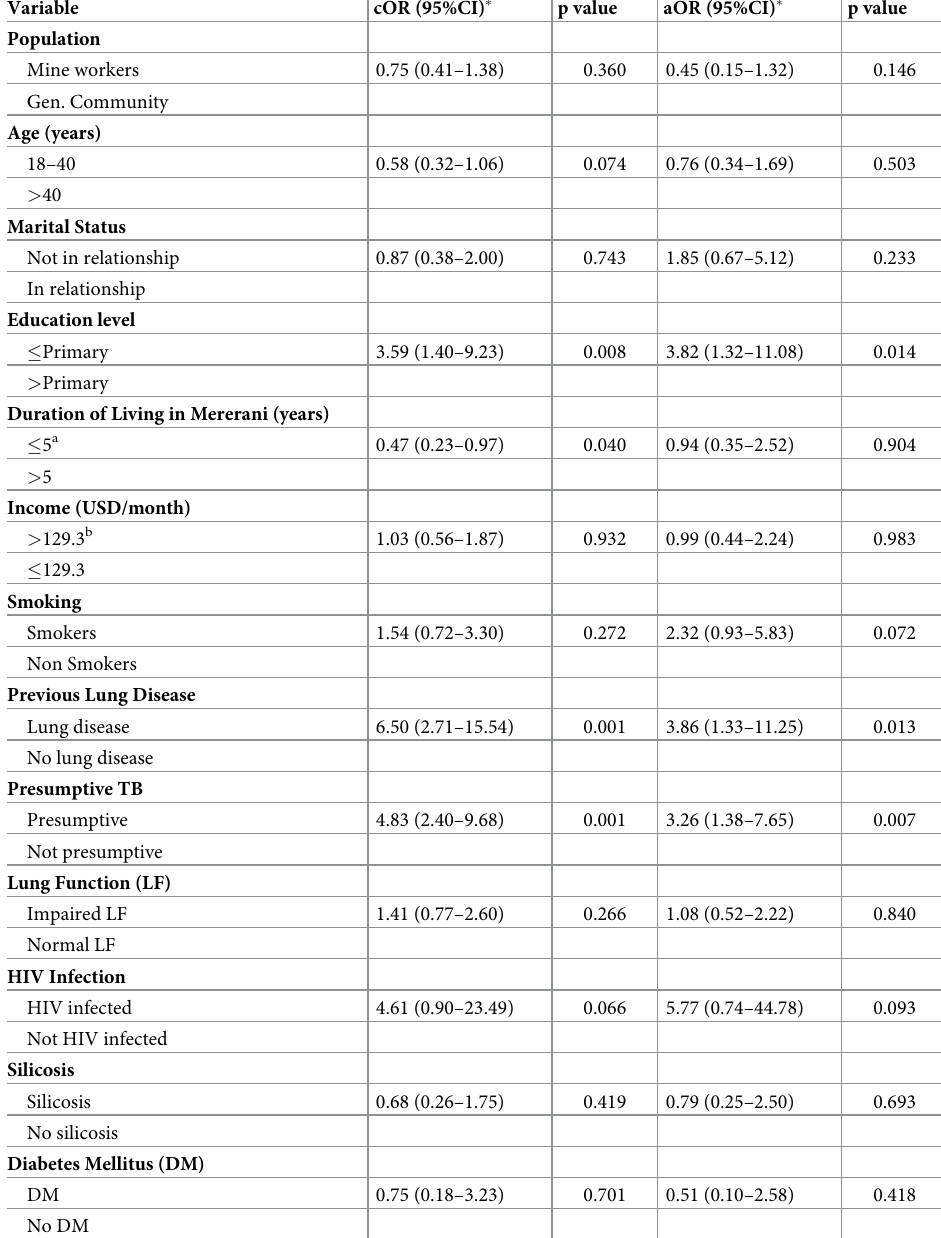
Table 3. Factors associated with tuberculosis among mining communities in Mererani (N = 660).